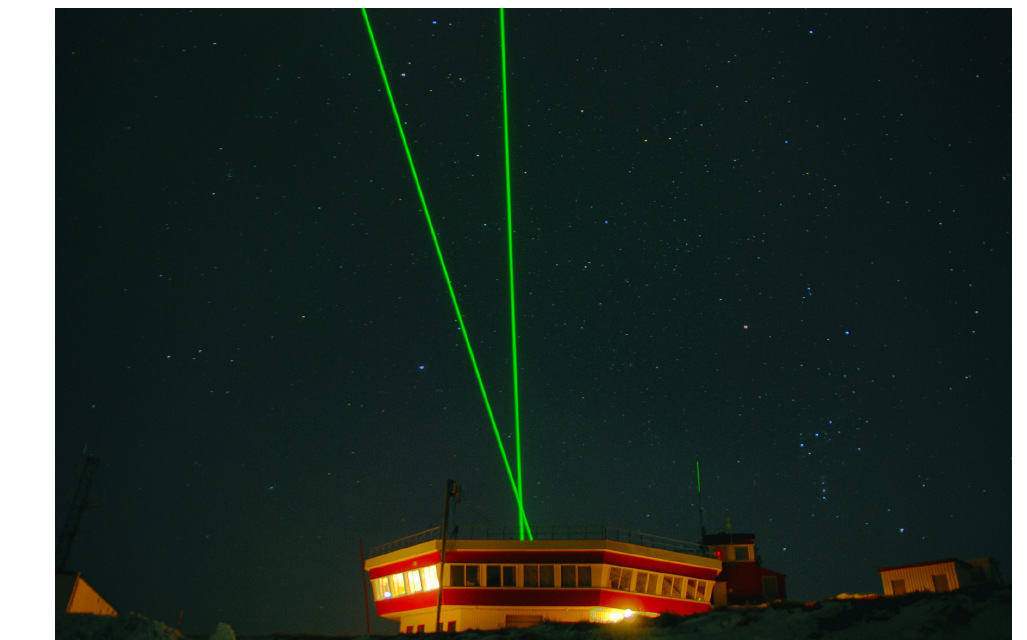
Figure 10. ALOMAR, the most important ground-based observatory at ARR/ASC. Two laser beams are visible.